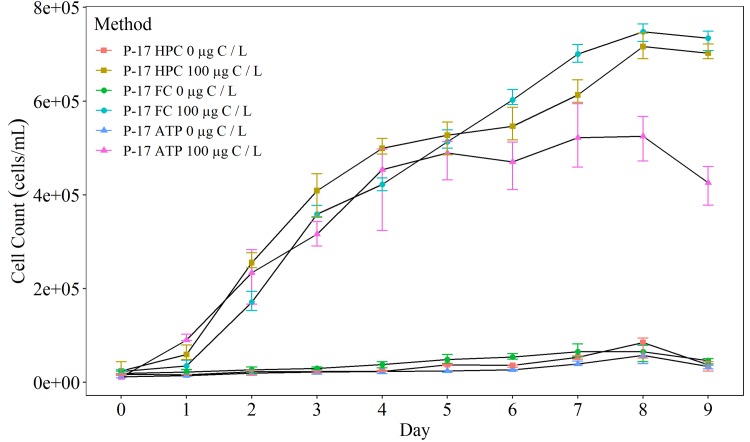
Comparison of P-17 cell concentrations when enumerated using heterotrophic plate counts (HPC), flow cytometry (FC) or adenosine triphosphate (ATP) over a nine day period.Cells are grown on in solutions containing 0 μg acetate carbon / L (control), and 100 μg acetate carbon / L. HPCs are recorded as CFU / mL and total cell counts (TCC) are recorded as cells / mL. ATP luminescence units converted to cells / mL using an ATP calibration curve. The average (n = 3) cell counts (± one standard deviation) are plotted.